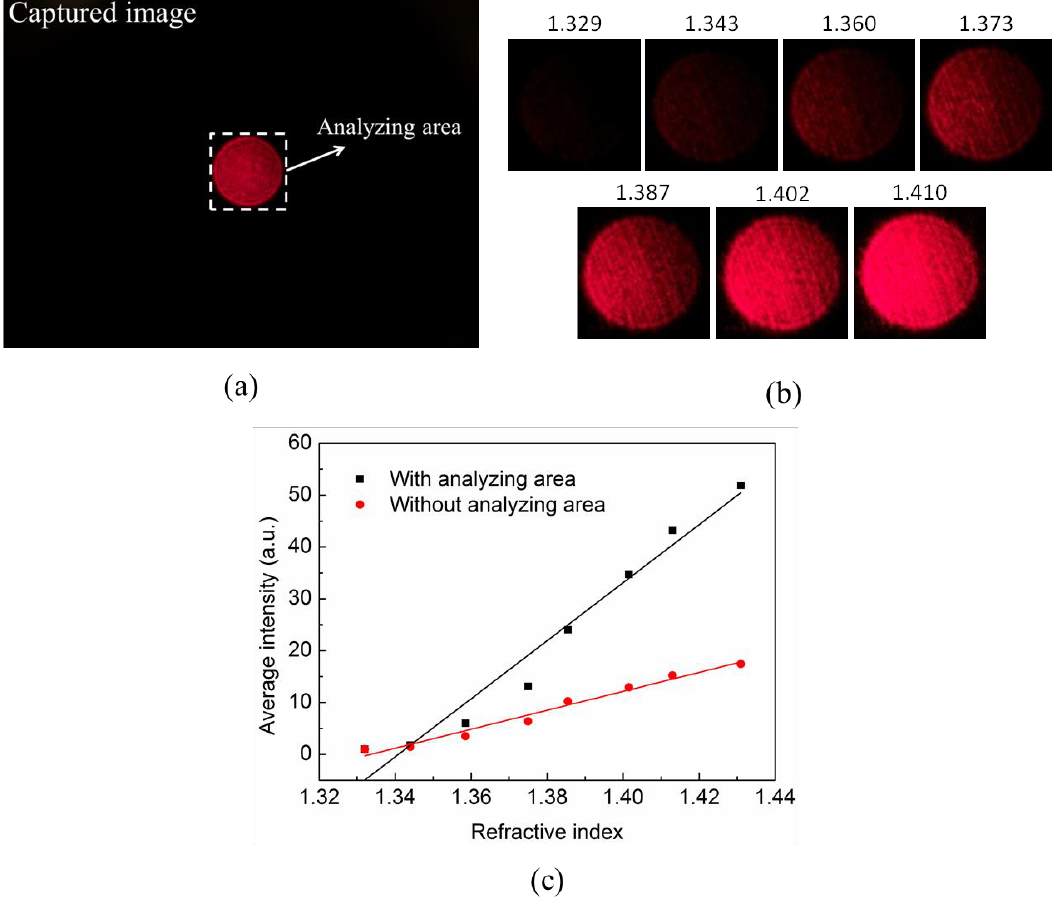
Figure 5. ( a ) The capture image from the front camera of a smartphone. The selected area for the intensity analysis; ( b ) captured image in the selecting area for test solutions with refractive indices; and ( c ) the relation between the average intensity and refractive index with and without the selective area.